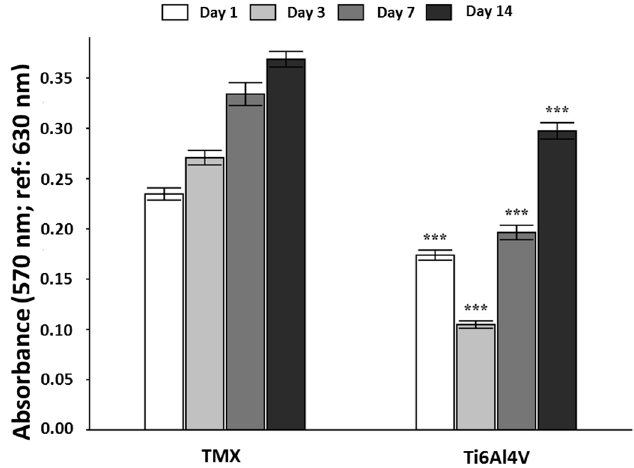
Figure 12. Absorbance measurements obtained after using Alamar Blue™ assay for cultured human osteoblasts seeded on the TMX control and the HAp sol-gel-derived coating/Ti6Al4V system studied (*** p <